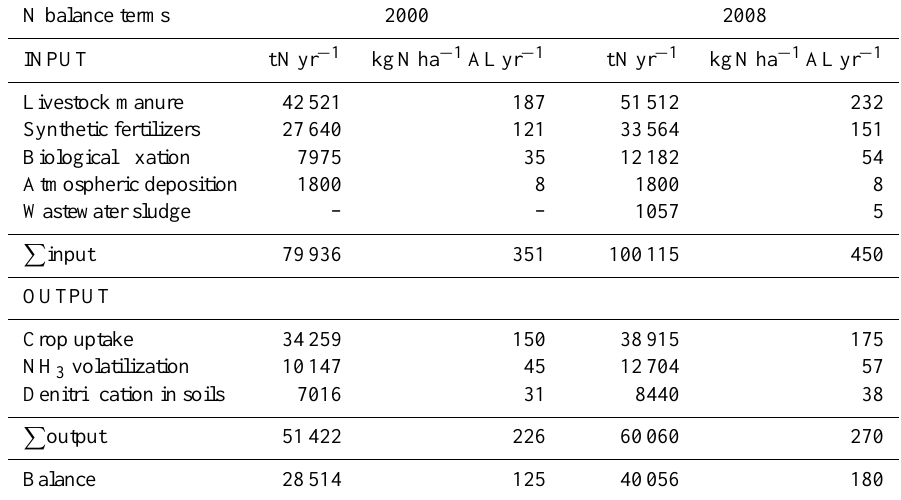
Table 1. Nitrogen balance in the Oglio River basin computed for the years 2000 and 2008. Data are expressed as tons of nitrogen produced or consumed per year in the whole basin or as kilograms of nitrogen produced or consumed per year per hectare of arable land